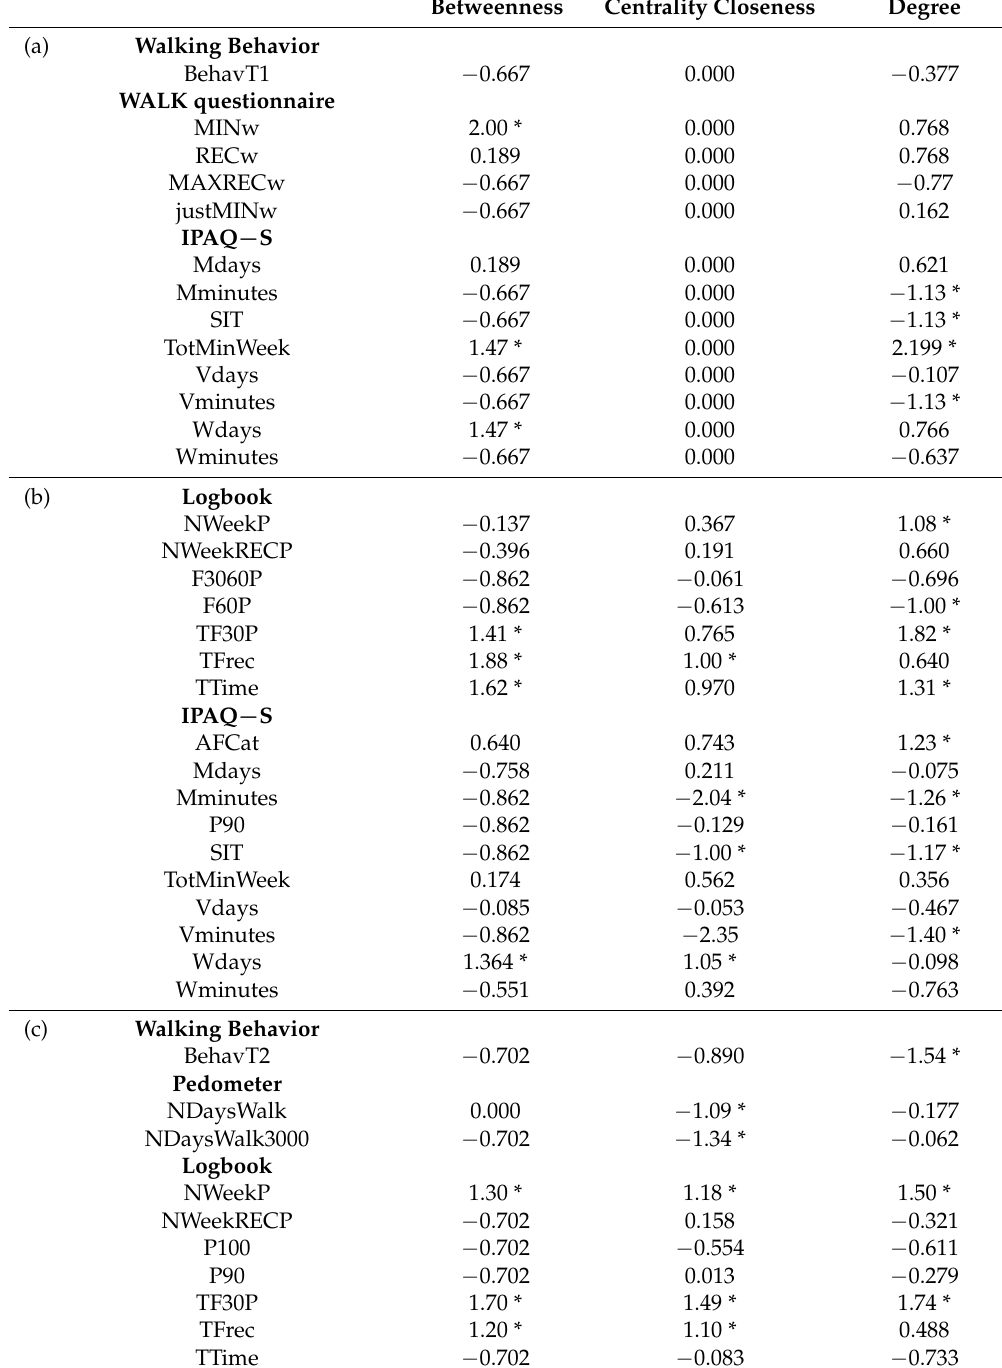
Table 3. Standardized centrality